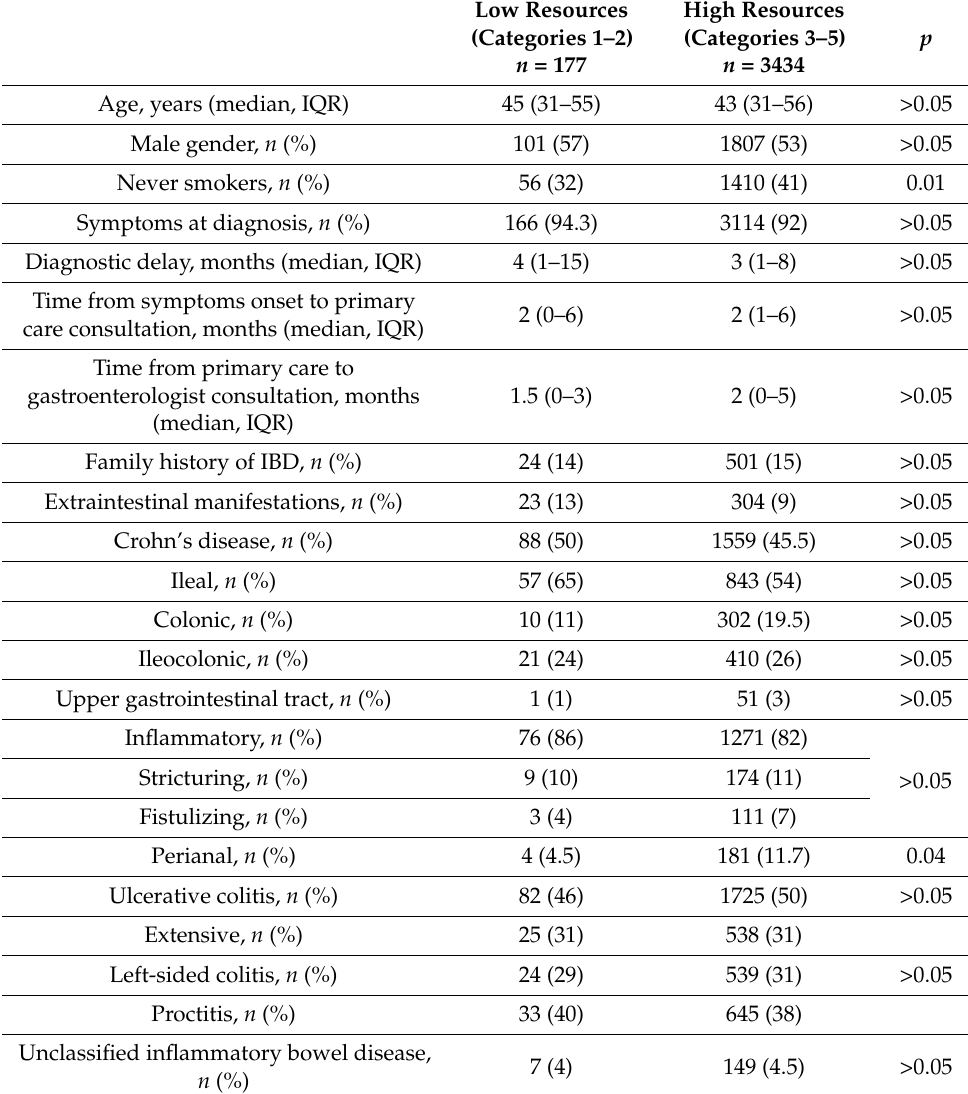
Table 4. Patients’ characteristics based on hospital